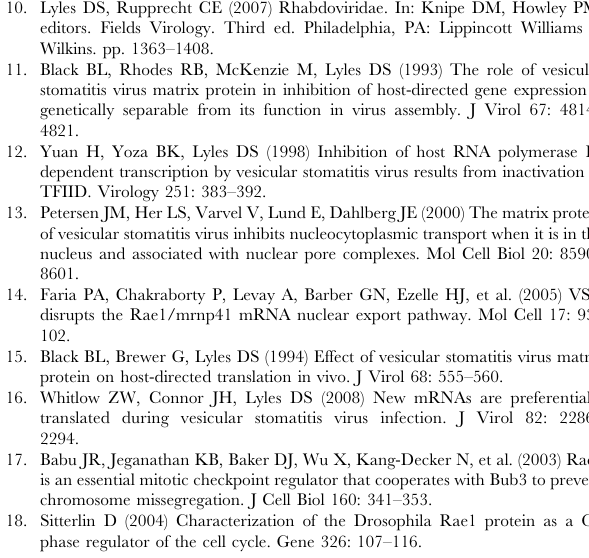
Figure S2 Analysis of post-translational modification of Rae1. Two-dimensional isoelectric focusing/SDS-PAGE was used to analyze bound and unbound fractions of cell lysates containing only endogenous Rae1 (upper panel) or containing HA-Rae1 (lower panel) after incubation with wt GST-M protein on glutathione beads. The fractions were probed for Rae1 and HA. The arrows depict the isoelectric points of known standards subjected to the same conditions. Figure S3 Effects of silencing the expression of Nup98 on host and viral protein synthesis. ( A ) HeLa cells were transfected with Nup98 siRNA or non-targeting (NT) siRNA. 72 hours post-transfection, cells were mock infected or infected with rwt virus for the indicated times and labeled with [ 35 S ] methionine for 10 min. Lysates from Nup98 siRNA cells or NT siRNA cells were analyzed by SDS-PAGE and phosphoimaging. Shown is a phosphoimage with the viral proteins indicated on the right. ( B ) Quantification of host protein synthesis expressed as a